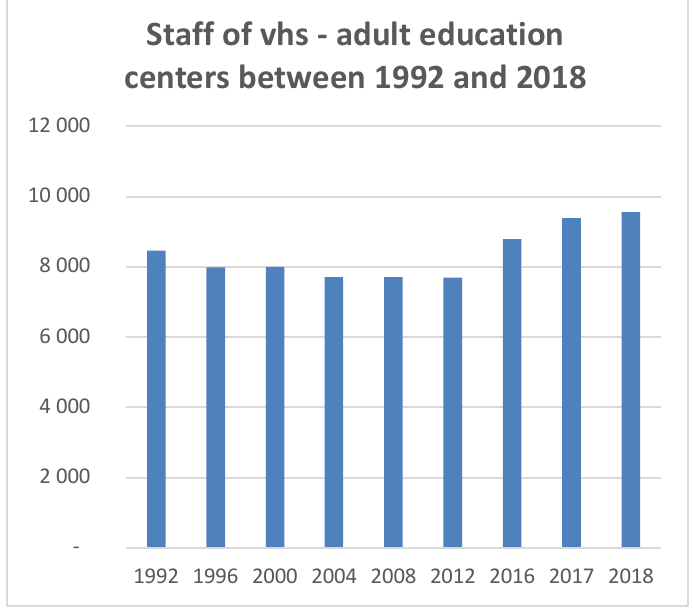
Figure 4. VHS staff (management, administration, and program planners) between 1992 and 2018. (Source: dvv-Statistik. Data processing is my own.)